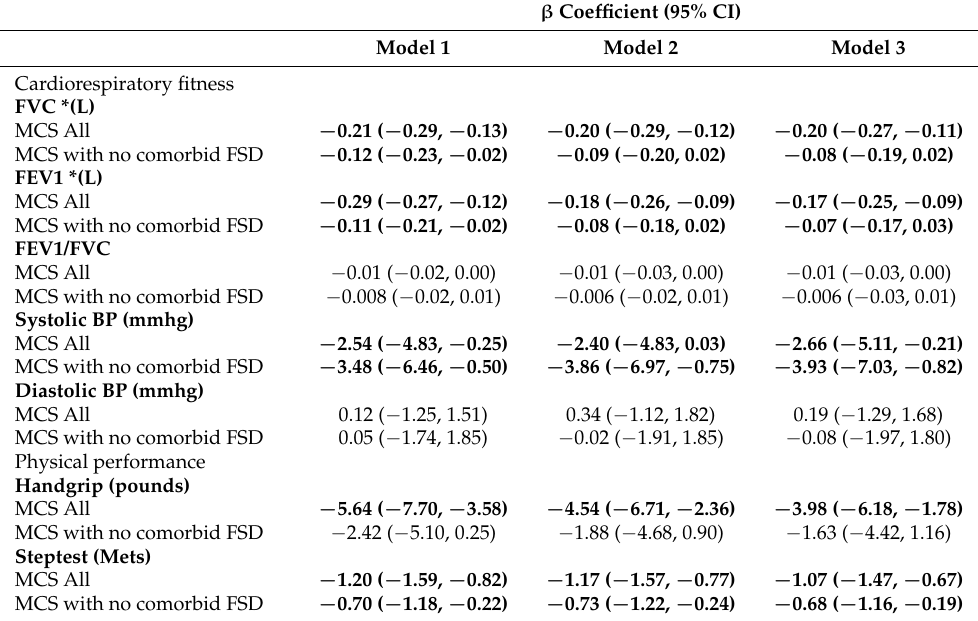
Table 3. Association between cardiorespiratory fitness, physical performance and MCS All or MCS with no comorbid FSD compared to